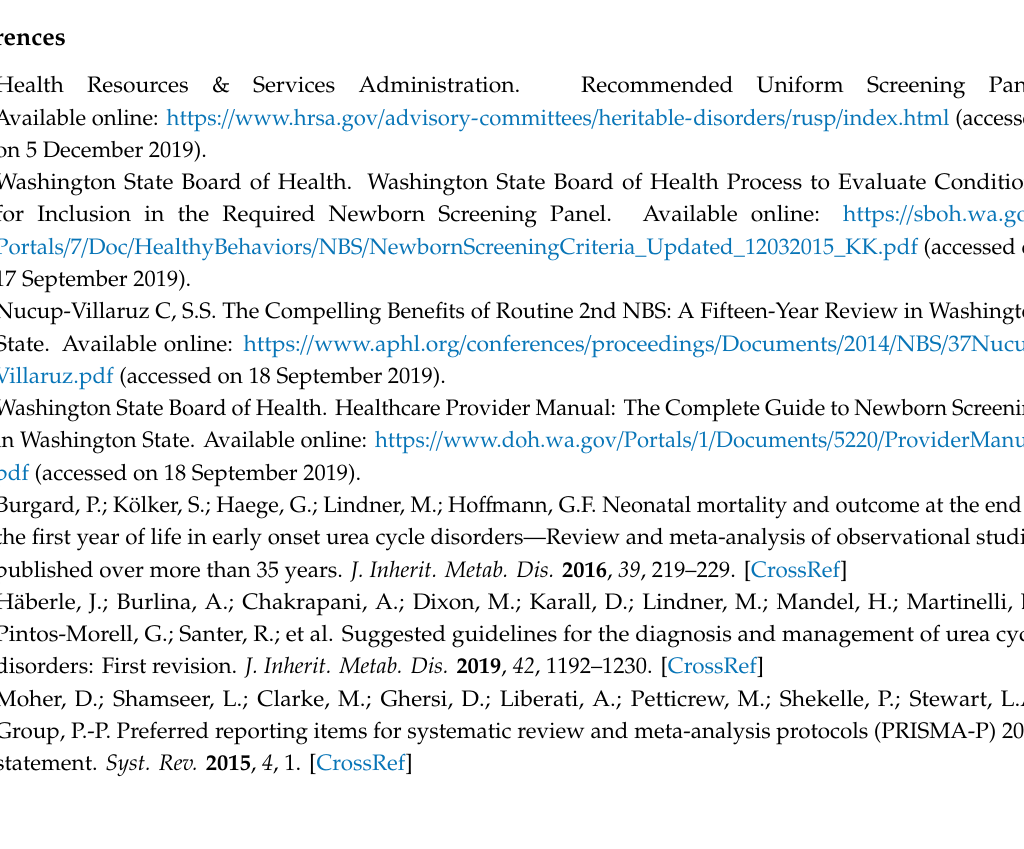
Figure S1. Selection criteria for articles included in the study. Table S1. Prisma Checklist. Table S2. Summary of Literature Included in Systematic